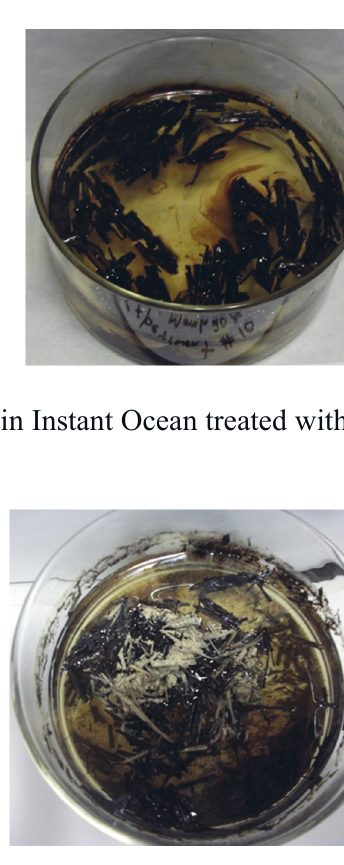
Figure 9. A bitumen sample in Instant ocean treated with CaO-coated charred hay sample at room temperature (23 °C) and time = 336